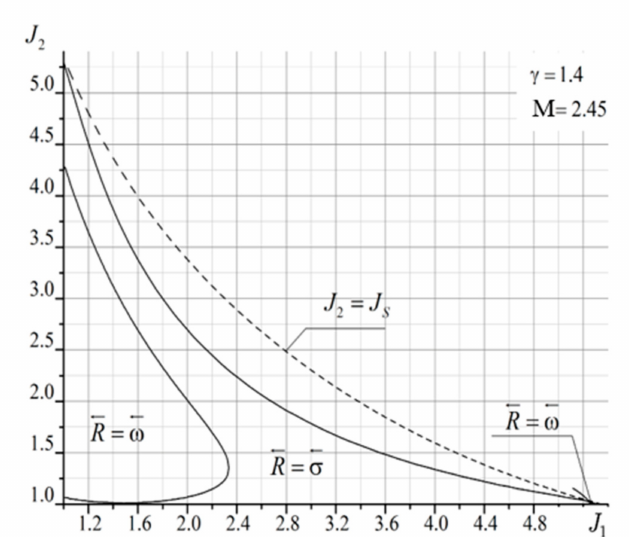
Figure 14. Domains of existence of various types of reflected discontinuity. As the Mach numbers decrease, region R ≡ ω shifts to the left and upward, until, at M = 2.45, another region R ≡ σ appears in the region of small J 1 (Figure 14). This moment corresponds to the tangency of the iso-Mach line contour at M = 2.45 to the horizontal axis in Figure 12. With a further decrease in the Mach number, the iso-Mach line contours are located entirely above the horizontal axis (Figure 14). To design the optimal external compression inlet with two oblique shocks, one can choose any point in Figures 13–15 belonging to region R ≡ σ , so that J 1 = J 2 . In the limiting case, it can lie on the iso-Mach line contours shown in Figure 10. It can be seen that, for Mach numbers close to M = 3, region R ≡ σ , in which two shocks can be chosen so that condition J 1 = J 2 is satisfied, is very narrow.